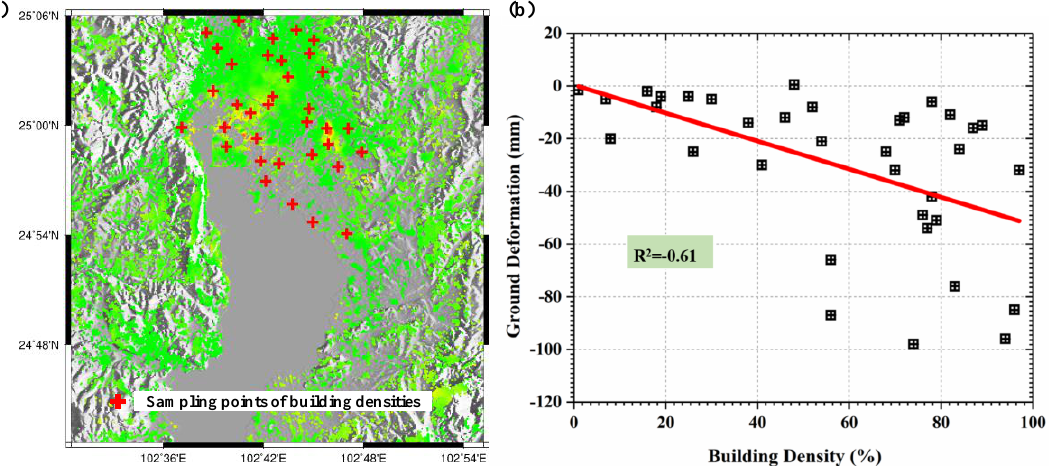
Figure 21. The distribution of sampling points of building densities ( a ) and the relationship between ground deformation and building density ( b ).